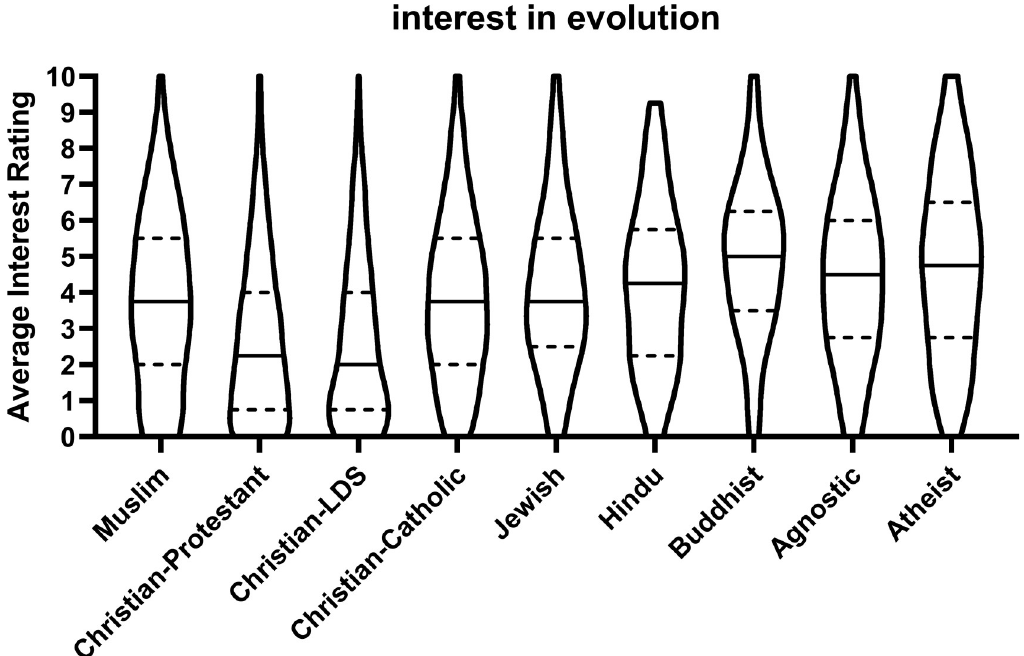
Fig 2. Interest in evolution. Violin plots of students’ average interest in taking an elective course on evolution, doing undergraduate research on evolution, studying evolution as part of their career, and becoming an evolutionary biologist. The violin shapes are the densities of the data at each point on the y-axis. The solid black lines are the medians, and the top and bottom broken lines are the 75 th and 25 th percentiles of the